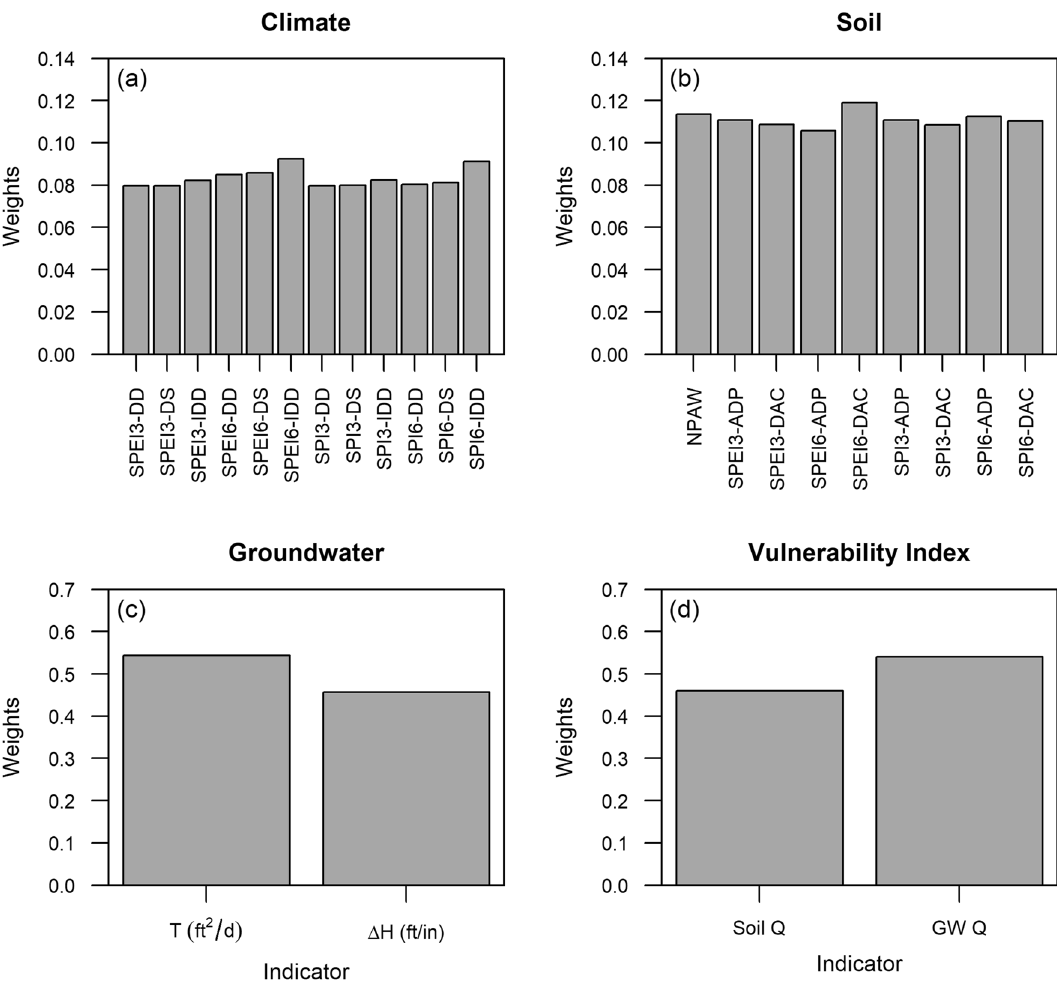
Figure 3. Estimated weights for various attributes used for computing ( a ) Climate Stress Index; ( b ) Soil Buffer Index; ( c ) Groundwater Buffer index and ( d ) Overall Vulnerability